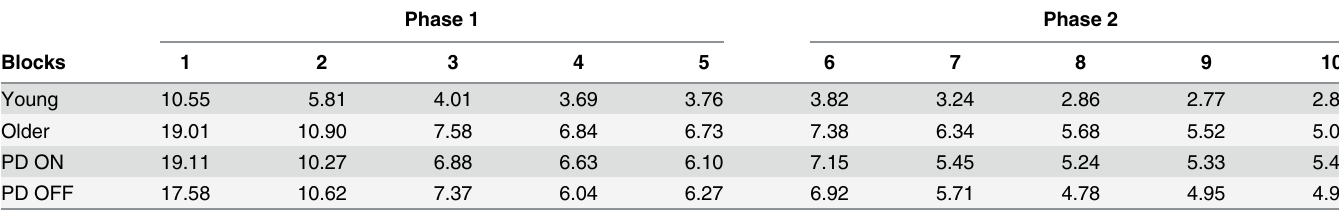
Table 3. Mean reading time in seconds for the repeated triads of all 10